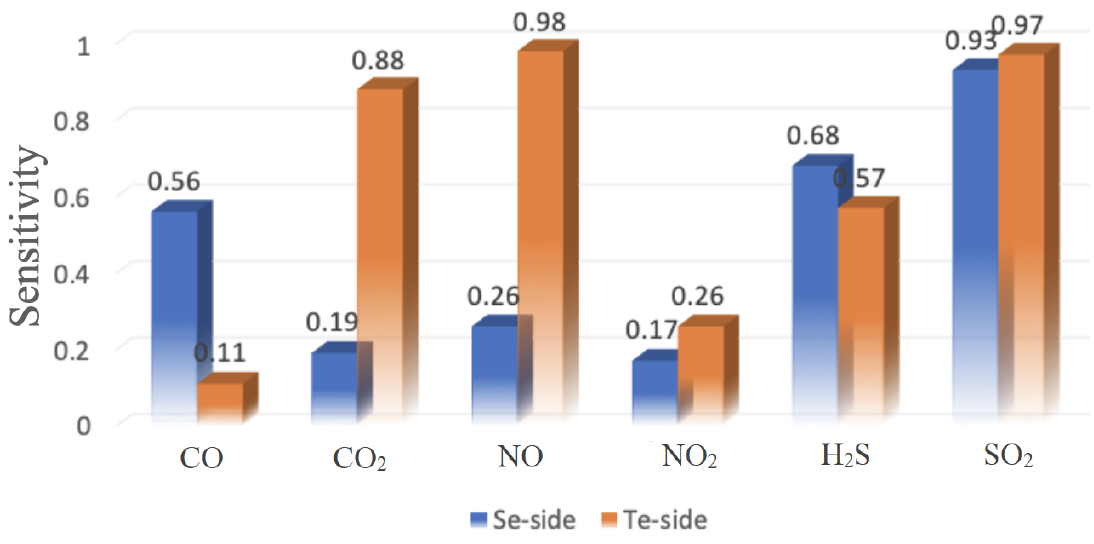
Figure 8. The sensitivity of CO, CO 2 , NO, NO 2 , H 2 S, and SO 2 gas molecules on the surface of the Janus NbSeTe monolayer at a voltage of 0.3